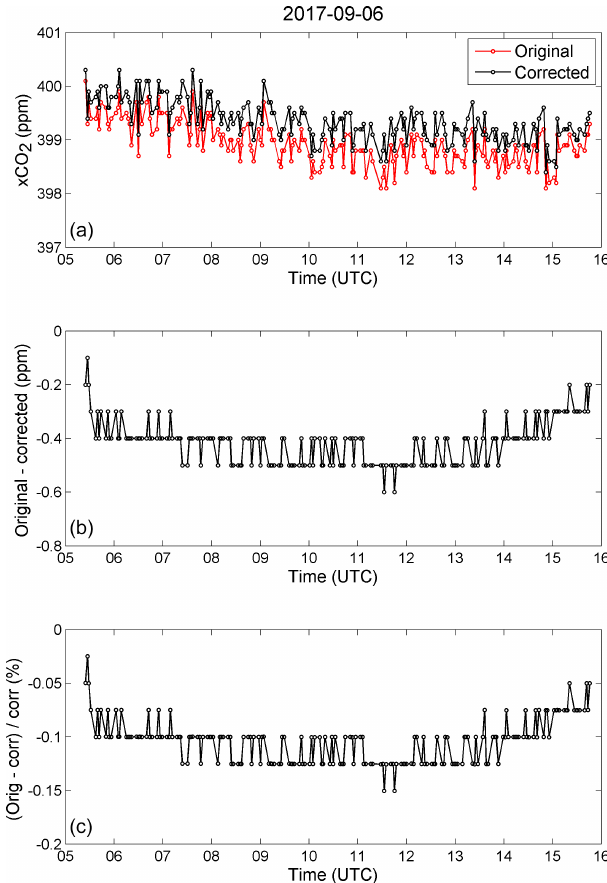
Figure A3. (a) Plot showing the original (red) and non-linearity- corrected (black) XCO 2 values for 1d of measurements performed on 6 September 2017 by the Bruker 125HR Sodankylä TCCON in- strument. Panel (b) shows the difference between the original and the corrected XCO 2 values. Panel (c) shows the relative difference (original − corrected) / corrected in percentage for the XCO 2 val-